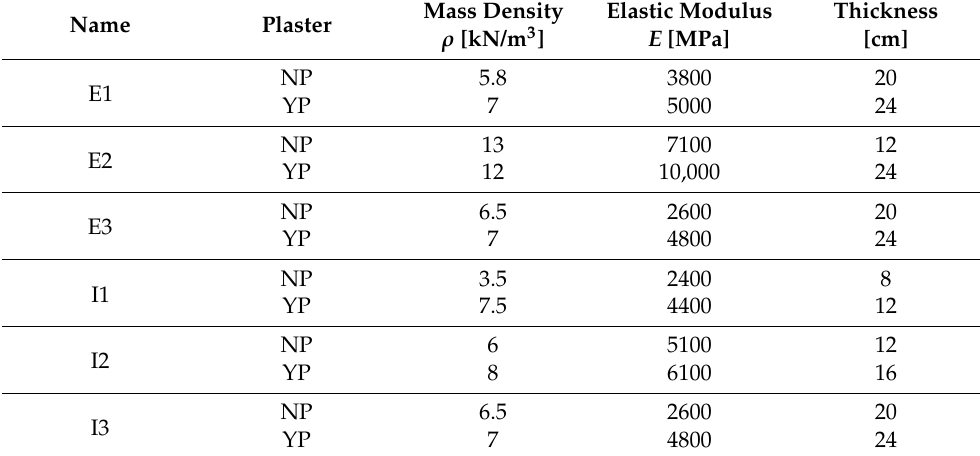
Table 6. Mechanical properties of the infill walls adopted in the modelling (to be reduced by λ 2 ).